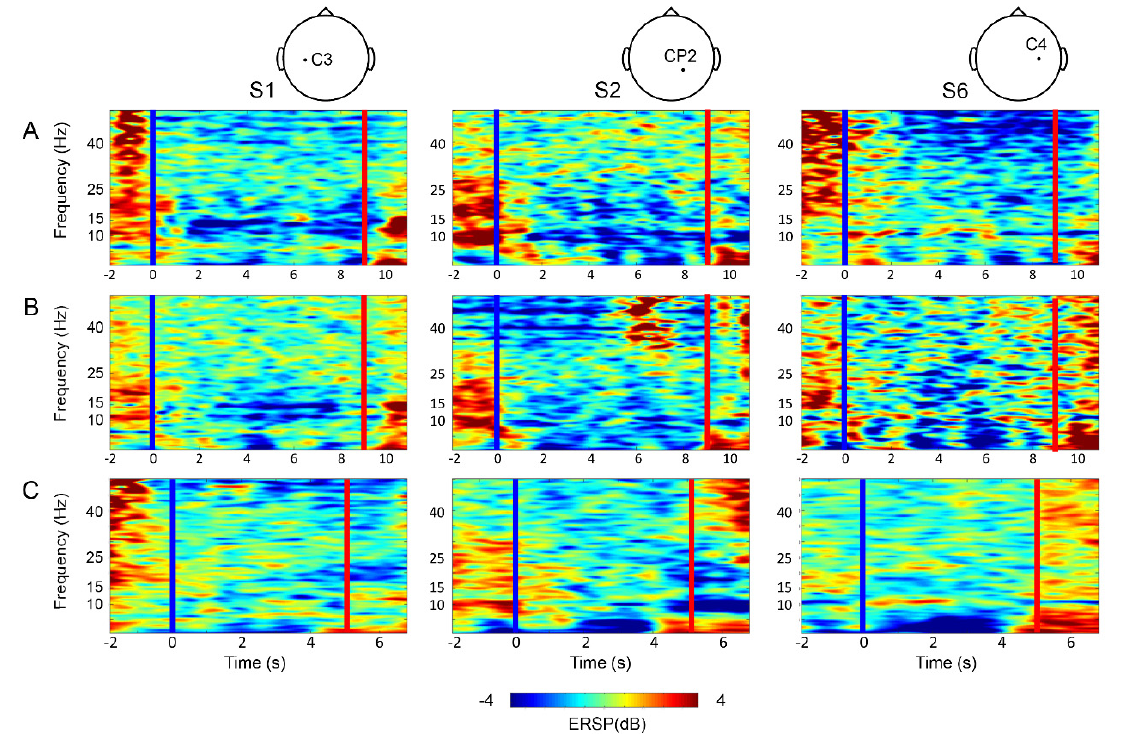
Figure 8. The event-related spectral perturbation (ERSP) of trial averaged power spectrogram plot; ( A ) Gait MI, ( B ) Sit MI, and ( C ) Do-nothing from top to bottom. The blue vertical line (time 0) represents cue onset, and the red line depicts offset. Subjects engage MIs at time 1 to 9 s and Do-nothing at 1 to 5 s.